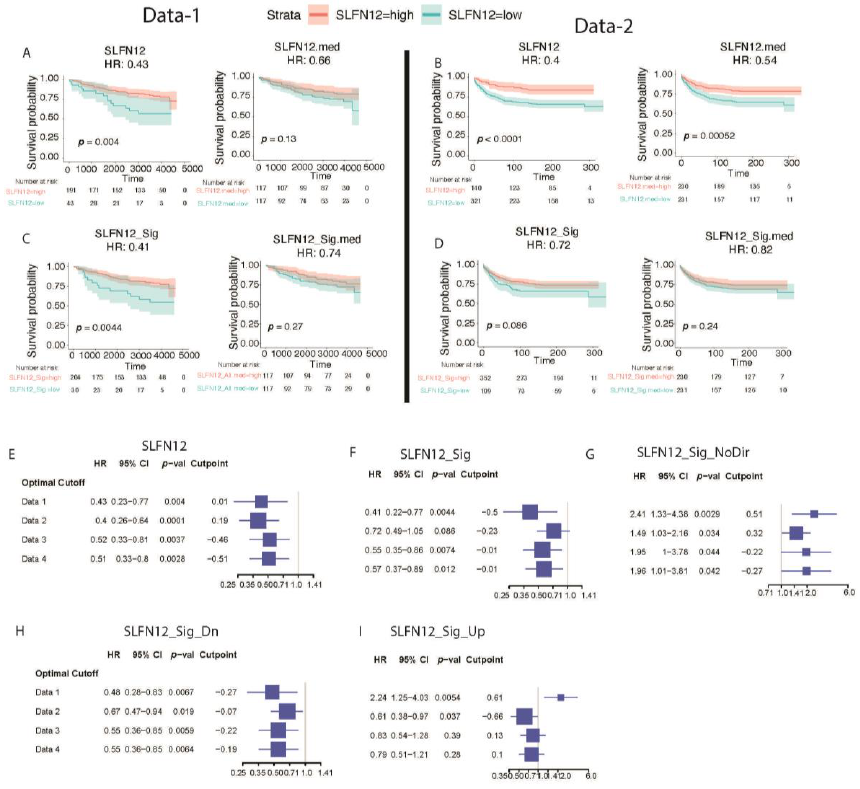
Figure 9. Kaplan–Meier curve describing the relapse-free survival (RFS) association of SLFN12, SLFN12 signature, and SLFN12 downregulated gene sets with the survival probability based on ( A ) optimal cutoff and ( C ) median score for Data-1. Kaplan–Meier curve describing the distant metastasis-free survival (DMFS) association of SLFN12 and SLFN12 signature with the survival probability based on ( B ) optimal cutoff and ( D ) median score for Data-2. Hazards Ratios (HRs) based on optimal cutoffs of Data-1, Data-2, Data-3, and Data-4 for signatures: ( E ) SLFN12, ( F ) SLFN12 Sig, ( G ) SLFN12 genes without direction, ( H ) SLFN12 downregulated genes, ( I ) SLFN12 upregulated genes as defined in the methods. Horizontal bars represent the 95% CIs of the